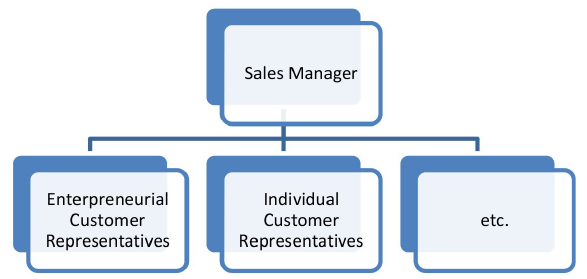
Figure 6. Customer based organizational scheme